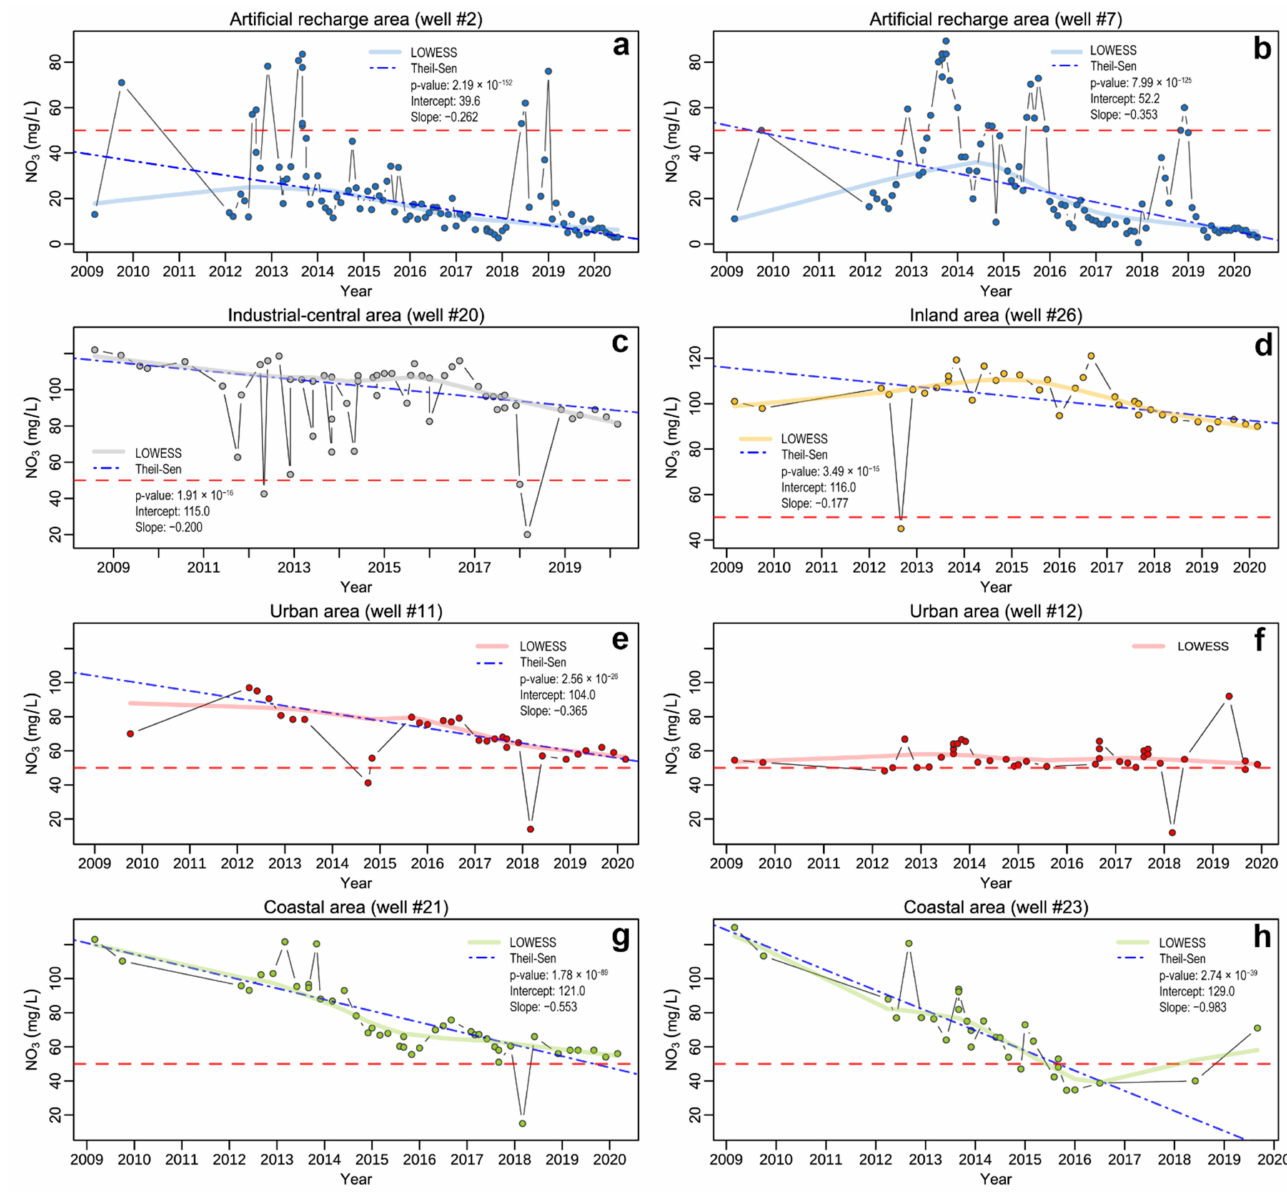
Figure 9. Nitrates time series from eight selected (( a ) well #2; ( b ) well #7; ( c ) well #20; ( d ) well #26; ( e ) well #11; ( f ) well #12; ( g ) well #21; ( h ) well #23) wells located in the different areas of the alluvial plain, with the following fitting lines superimposed: LOWESS smoother (line), Theil-Sen fit (blue dash-dotted line). Summary statistics of the Theil-Sen median-based linear regression models are reported in each plot. The horizontal red dotted line marks the Law Limit of 50 mg/L defined by the Italian